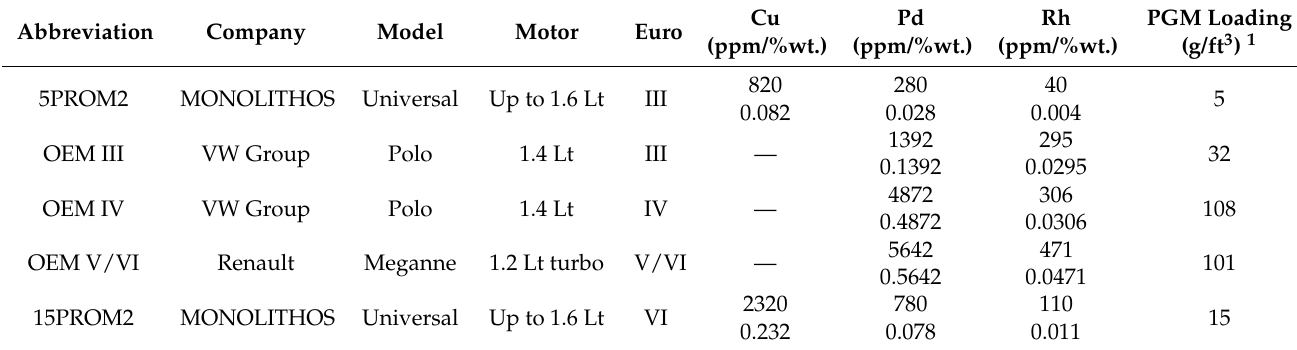
Table 1. PGMs and copper loading for commercial Three-Way Catalysts TWCs (benchmark catalysts) and PROMETHEUS full scale catalysts produced.